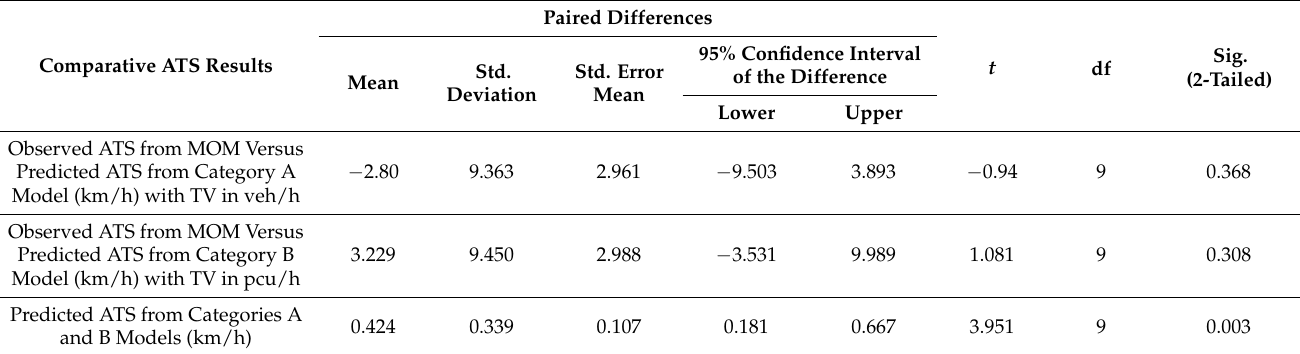
Table A4. Results of paired t -test for model of cross-section case of [M1, NL2, SF0].